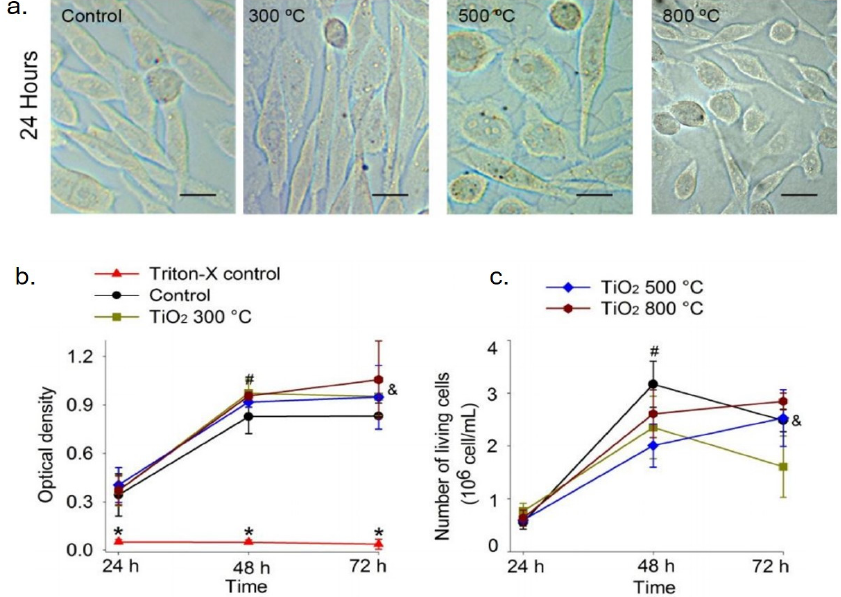
Figure 6. ( a ) Representative optical microscopy images of Chinese Hamster Ovary (CHO-K1) cells cultured on TiO 2 thin films annealed at 300, 500, and 800 °C after 24 h. No significant differences were observed with respect to control. Scale bar = 20 µ m for all the images. ( b ) Optical density after 24, 48, and 72 h of Triton-X control (borosilicate glass plus Triton-X), control (borosilicate glass), and TiO 2 films in cells. ( c ) Number of unstained CHO-K1 cells (in millions) on control substrate and on TiO 2 thin films after 24, 48, and 72 h. * Triton X-100 24 h vs. Triton X-100 48 or 72 h; # 24 h vs. 48 h; and & 24 h vs. 72 h. Reprinted from [144].